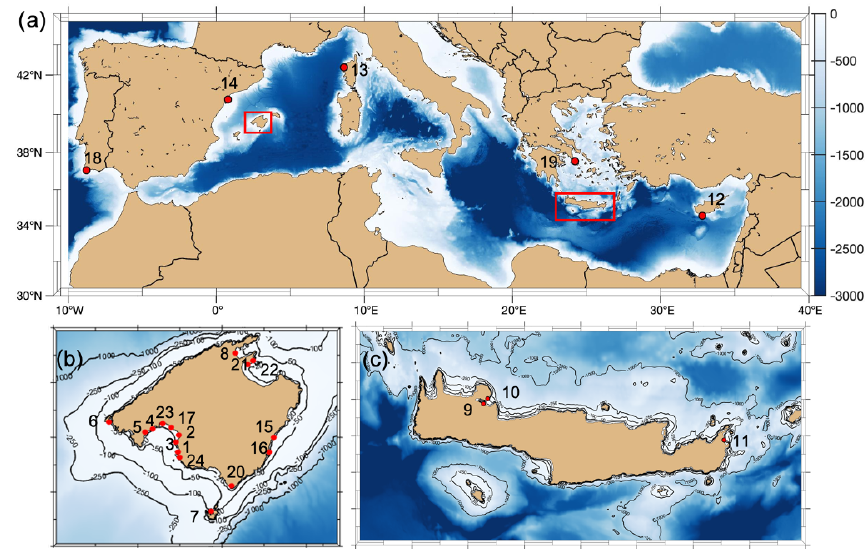
Figure 1. Location of sampling sites with the numbered ID as described in Tables 1 and 2 included in this compilation (map generated with the M_Map package of MATLAB,